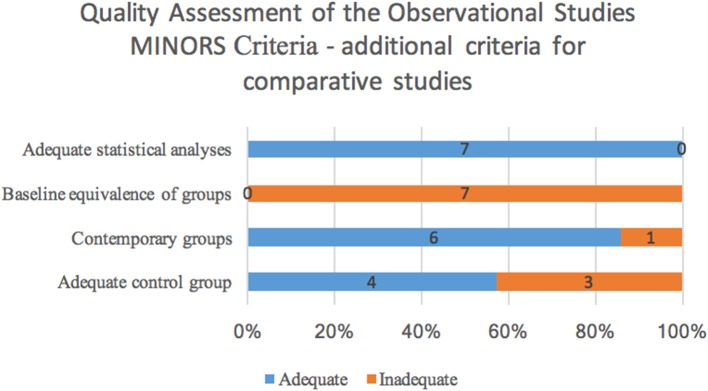
Distribution of the adequacy of the four additional MINORS criteria assessing comparative studies, showing the amount of articles scoring adequate or inadequate for the criteria.